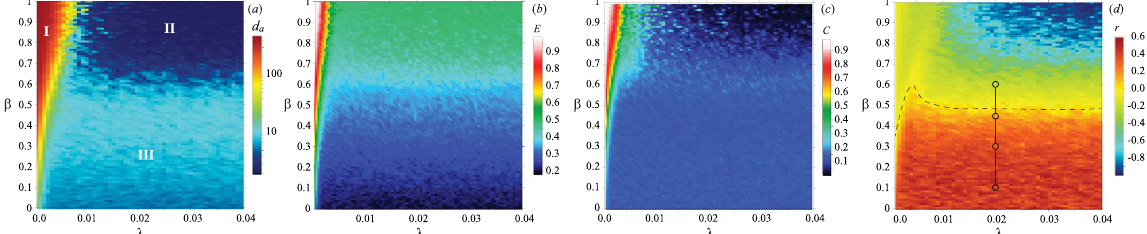
Figure 3. 2D-plots reporting the values of several network’s topological measures in the parameter space ( λ , β ): ( a ) the average degree over the network (given in log scale), ( b ) the graph’s efficiency E , ( c ) the clustering coefficient C , ( d ) the assortativity coefficient r . See the main text for all the definitions. For each panel, the color code is reflected in the corresponding legend. The dashed contour line in panel ( d ) connects all points where r = 0. Other labels appearing in panels ( a , d ) are defined and discussed in the main text. All networks have N = 500